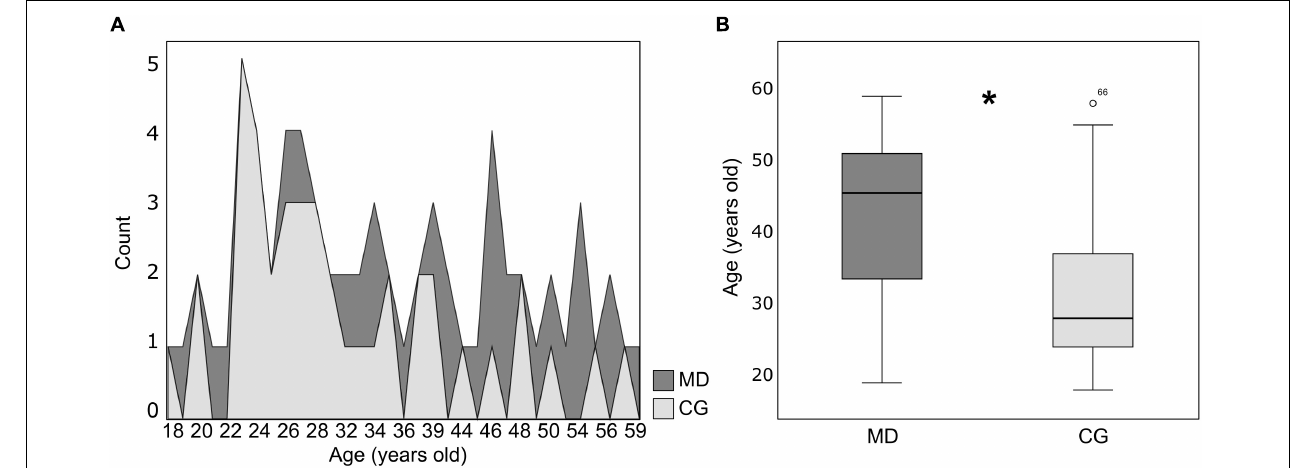
FIGURE 2 | (A) Distribution of age (years old) for patients (MD, dark gray color n = 28) and healthy controls (CG, light gray color n = 41). (B) Box plot of age (years old) (median ± Q75% and Q25%) for the patients (MD, n = 28) and healthy controls (CG, n = 41). Mann–Whitney test, ∗ p ≤ 0.05, statistically significant difference between-groups.